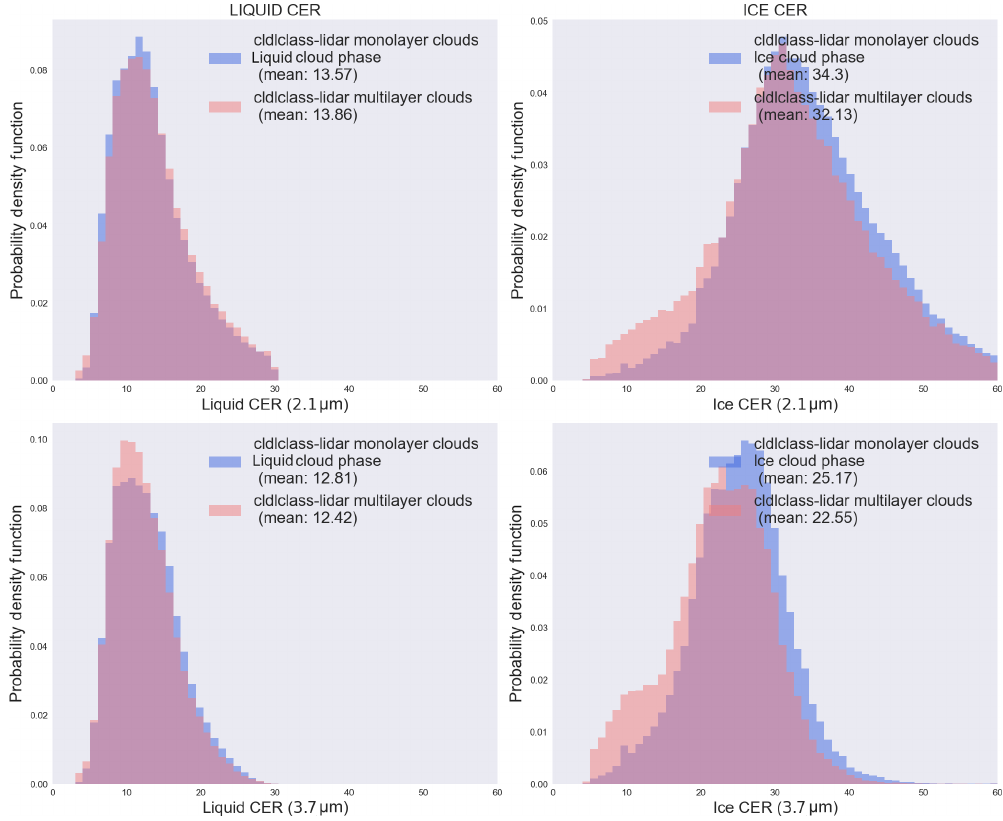
Figure 10. The same as Fig. 9 but excluding the Pavolonis–Heidinger detection algorithm in the MYD06 multilayer cloud detection algo-